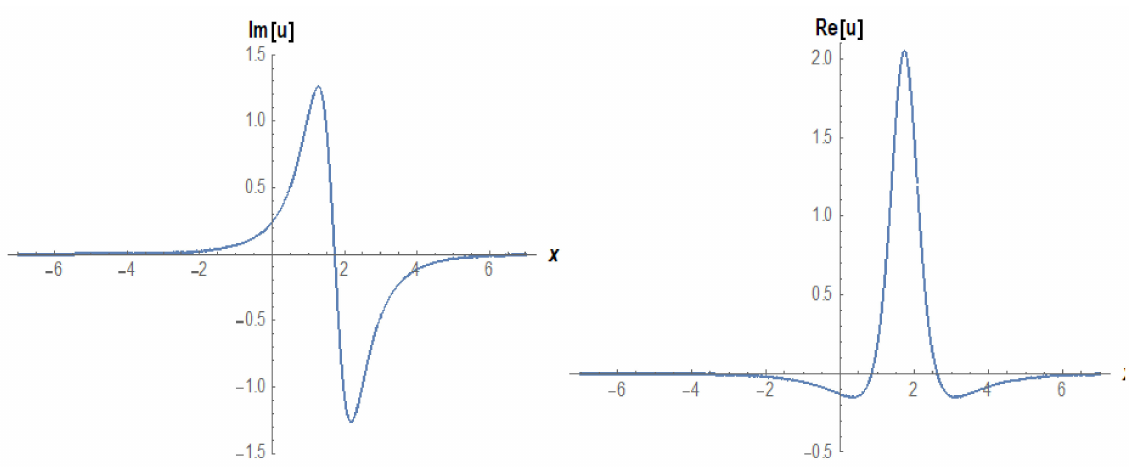
Figure 19. The 2D surfaces of Equation (30) under the values of ε = 5, t = 0.3, − 7 < x <